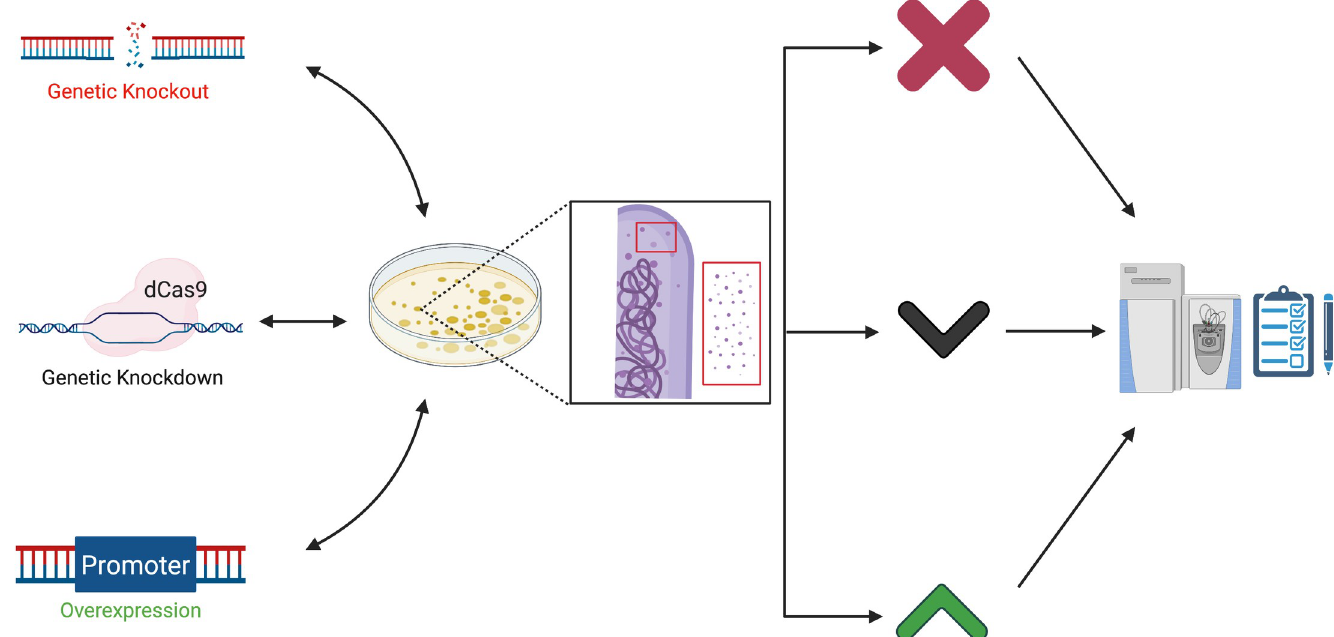
Fig 1. The genetic proteome. Manipulating the genome using genetic approaches (left) alters the cell-associated and naturally enriched proteomes derived from bacteria resulting in protein loss (X) or increased or decreased protein levels (up and down arrows). These are measured and confirmed or rejected using proteomic approaches (right). Together classical and analytical approaches further our understanding of how specific genes affect mycobacterial physiology and virulence. (Created with BioRender). dCas9, dead Cas9 protein.